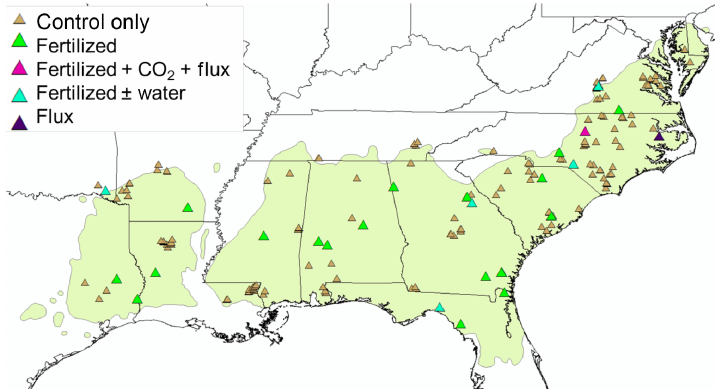
Figure 1. Map of loblolly pine distribution, plot locations used in data assimilation, and the experiment type associated with each plot. The control-only treatments were plots without any associated experimental treatment or flux measurements. Fertilized treatments were plots with nutrient additions. CO 2 treatments were plots with free-air concentration enrichment treatments. The flux treatments were plots with eddy-covariance measurements of ecosystem-scale carbon and water exchange. The water treatments included throughfall exclusion and irrigation experiments.